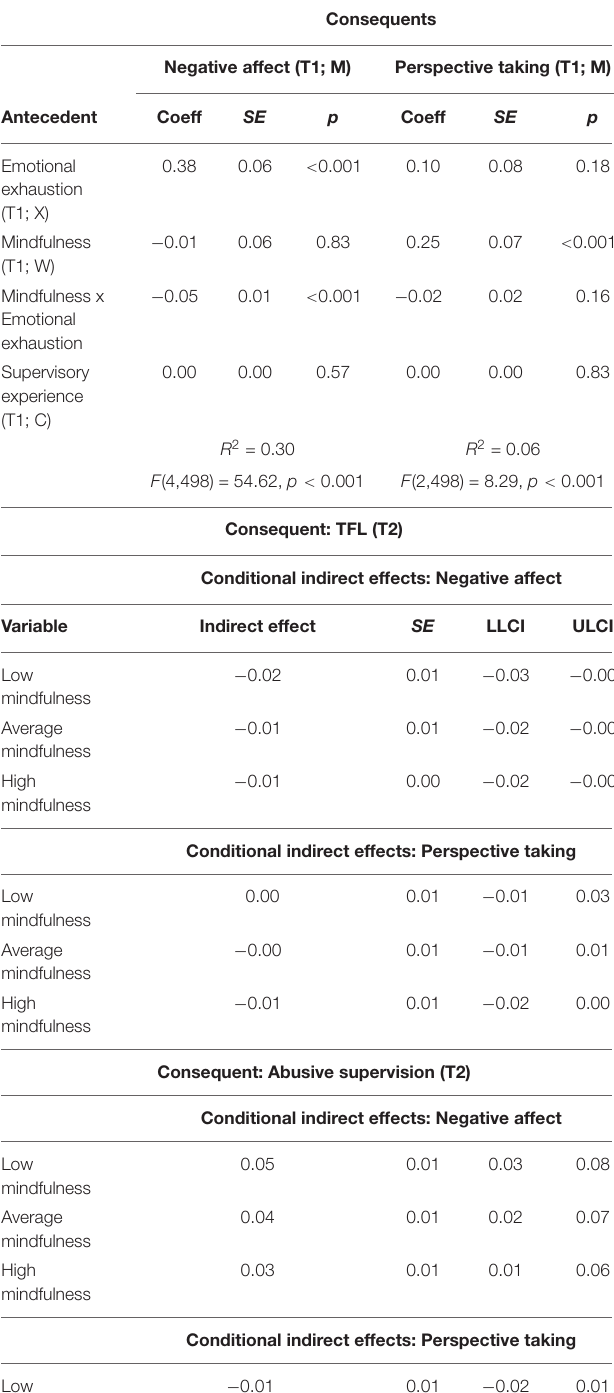
TABLE 4 | Results for moderated mediation